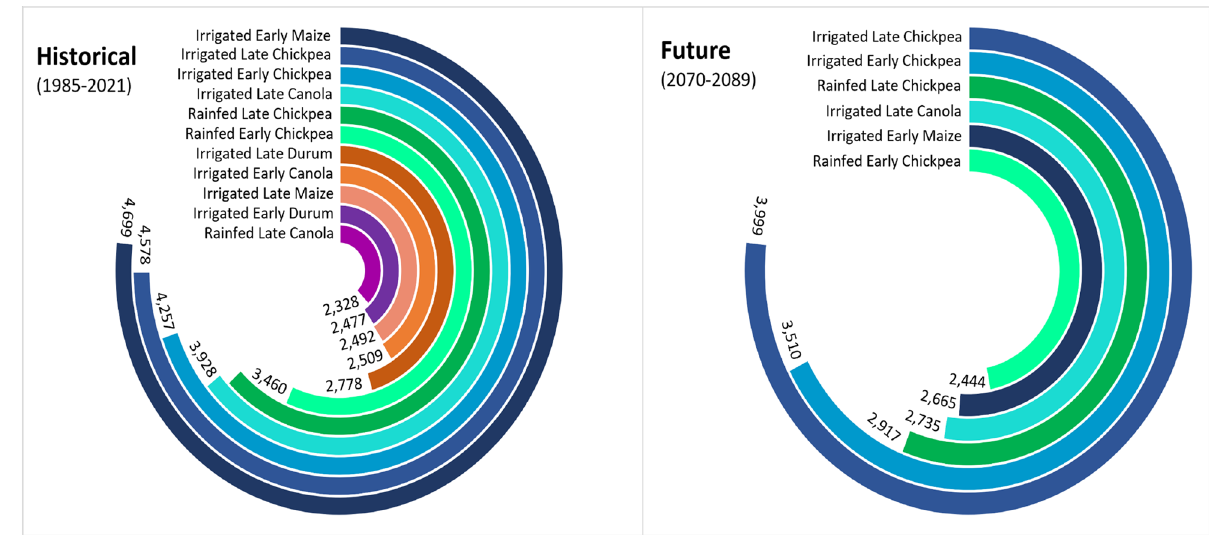
Figure 5. Most profitable farm systems under historical (1985–2021) and future (2070–2089) climates for early and late crop genotypes in dryland and irrigated conditions in a hot dry Australian cropping region with annual rainfall < 400 mm (Kerang, Victoria). The numerical values represent gross margins. Crops that were not profitable (negative gross margin) under future climates were removed. Other sites are shown in Table S5.